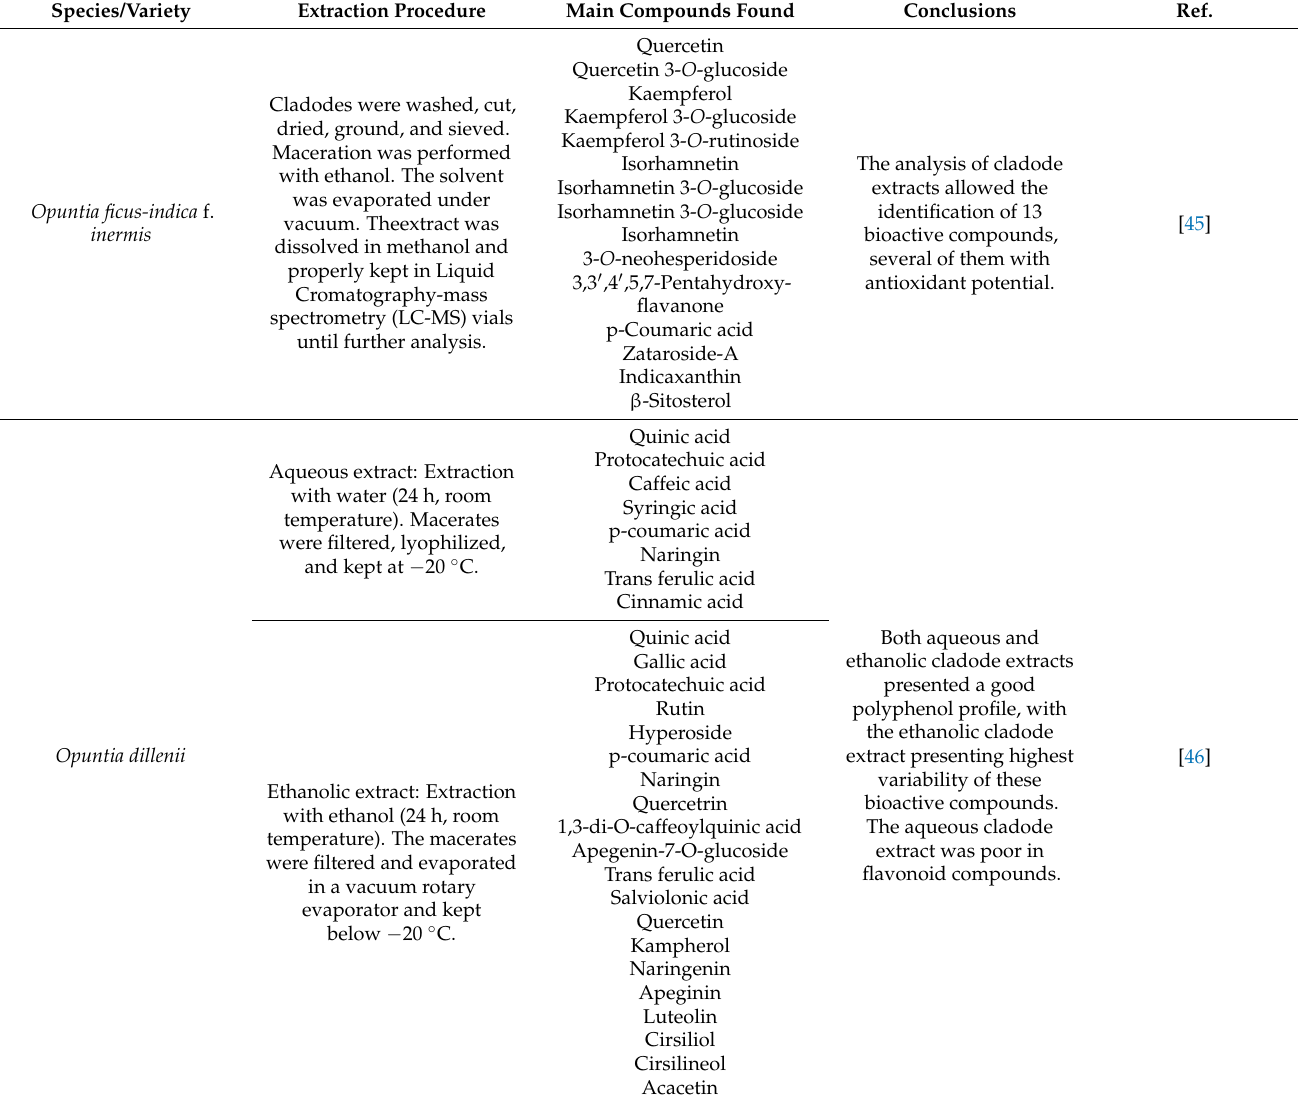
Table 1. Bioactive composition and extraction procedures of Opuntia spp.